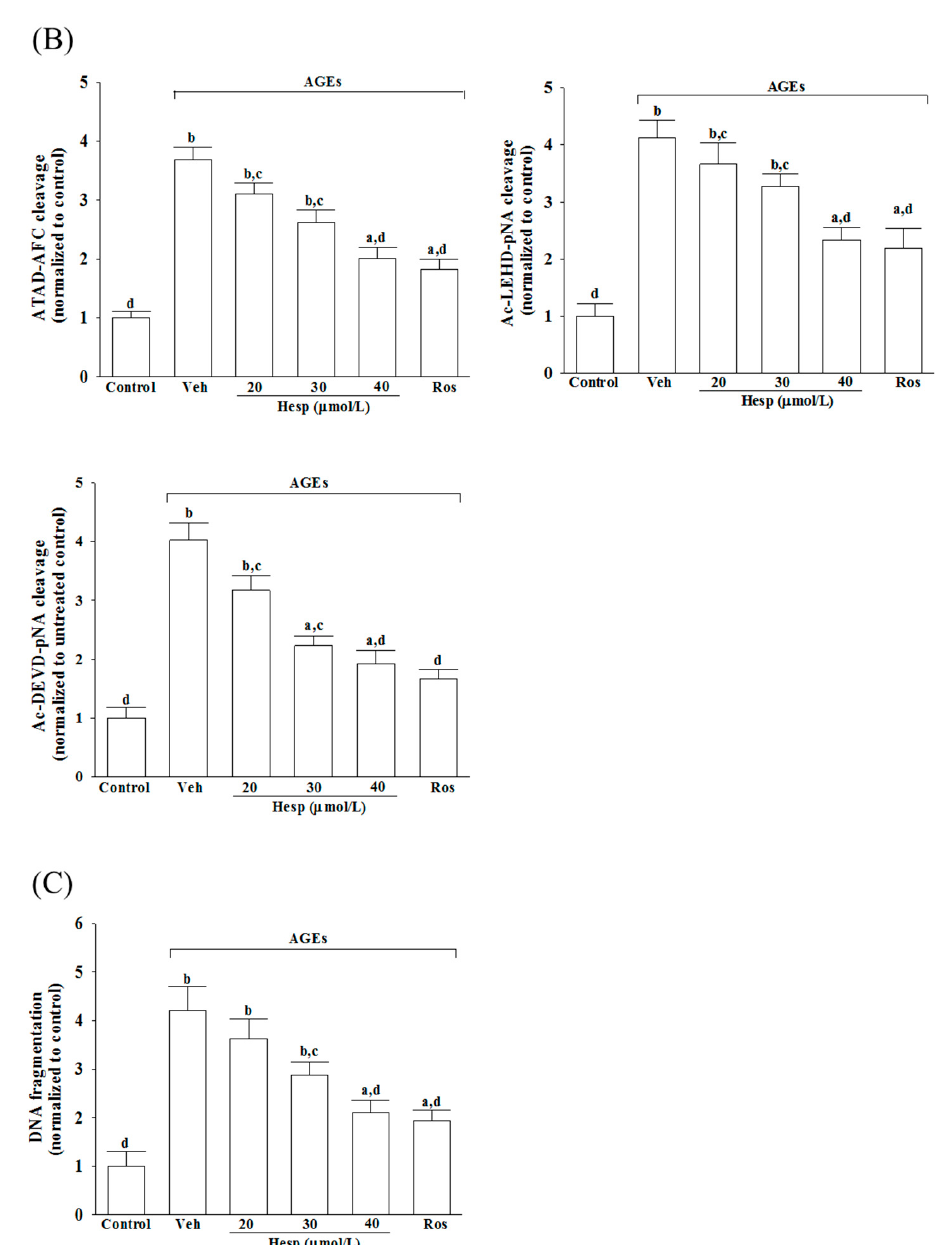
Figure 5. Analysis of ER stress-associated apoptosis in SH-SY5Y cells induced by AGEs. Cells were received 1 h pretreatment with hesperetin (hesp; 20–40 µ mol/L) or rosiglitazone (Ros; 10 µ mol/L), continued to 24 h AGE (200 µ g/mL) exposure. ( A ) A representative Western blot analyzes the relative levels of Bcl and Bax. Band densities were normalized with β -actin. The relative intensities of Bcl-2 to Bax (Bcl-2/Bax) were shown. ( B ) Analysis of caspase-12, -9, and -3-like activity. The caspase-12-like activity in cell lysates was quantified by fluorescent detection of the cleavage of substrate ATAD-AFC. The activities in caspase-9 and caspase-3 were evaluated by the cleavage of their respective substrates, Ac-LEHD-pNA and Ac-DEVD-pNA. ( C ) Quantification of apoptotic DNA fragmentation. The commercial kit quantified cytosolic histone-associated DNA fragmentation. The results are presented as the mean ± SD of five independent experiments performed triplicate (n = 5). a p < 0.05 and b p < 0.01 when compared to the data from the untreated control group (control). c p < 0.05 and d p < 0.01 when compared to the data from the vehicle (Veh)-treated cells. AGEs induced a 3.7-fold increase in caspase-12-like activity, which suffered a 2.1-fold and 1.9-fold reduction in SH-SY5Y cells pretreated with hesperetin (40 μ mol/L) or rosig- litazone (10 μ mol/L) (Figure 5B). The caspase-like activities in caspase-9 and caspase-3 increased by 4.1- and 4.0-fold in cells under AGE stimulation (Figure 5B). Hesperetin (40